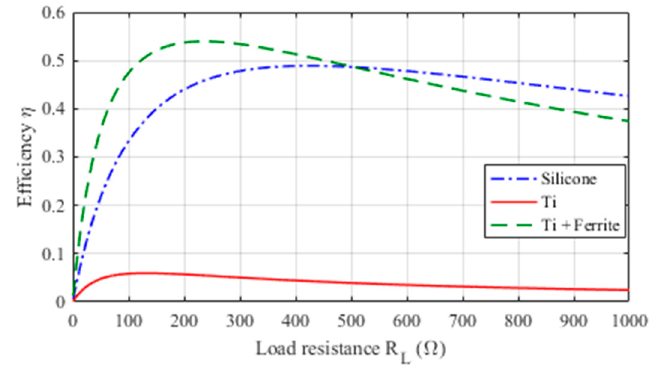
Figure 14. E ffi ciency η vs. load resistance R L for SP compensation Figure 14. Efficiency η vs. load resistance R L for SP compensation topology.